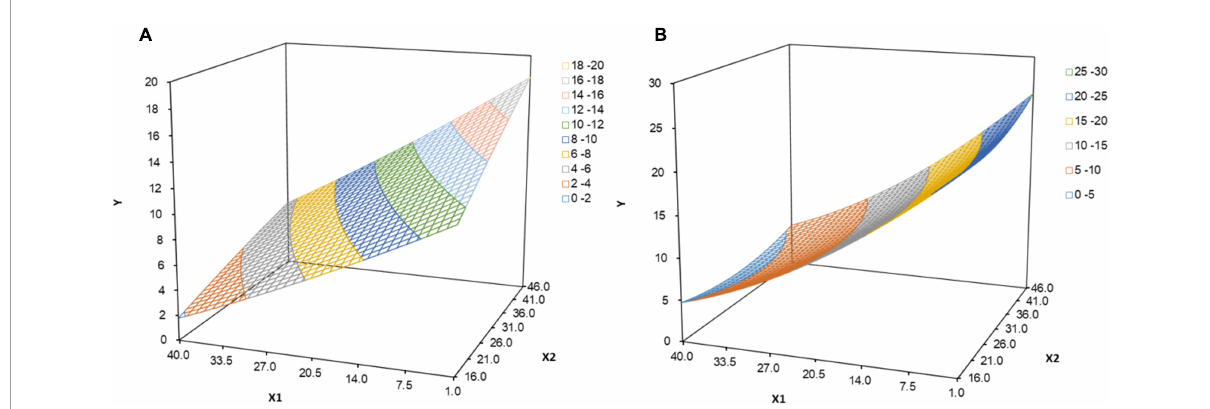
FIGURE1 (A) In the absence of adverse childhood experiences, the effect of resilience and fear of childbirth on psychological distress. X 1 : resilience, X2: fear of childbirth, Y: psychological distress. (B) When having adverse childhood experiences, the effect of resilience and fear of childbirth on psychological distress. X 1 : resilience, X 2 : fear of childbirth, Y: psychological